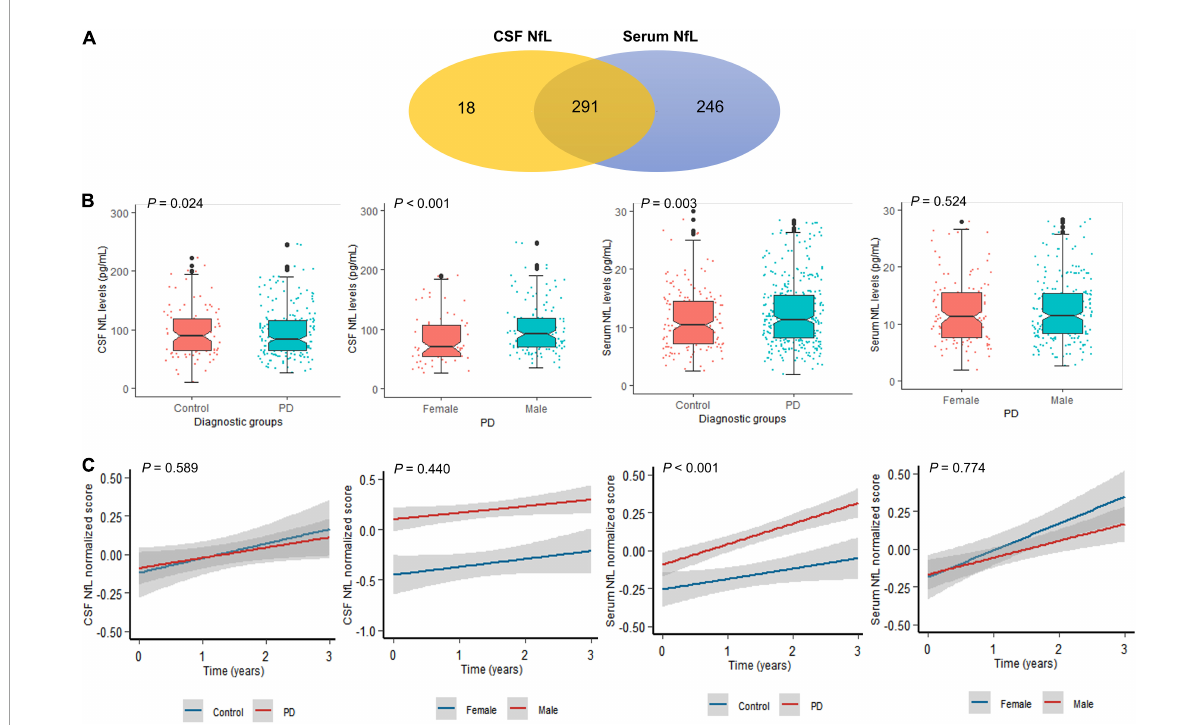
FIGURE1 Neurofilament light (NfL) levels between controls and patients with PD. (A) A total of 555 participants provided one serum and/or CSF sample for NfL measurement. A total of 291 participants provided both CSF and serum samples. (B) Baseline NfL levels of controls and patients with PD. (C) Longitudinal NfL values of controls and patients with